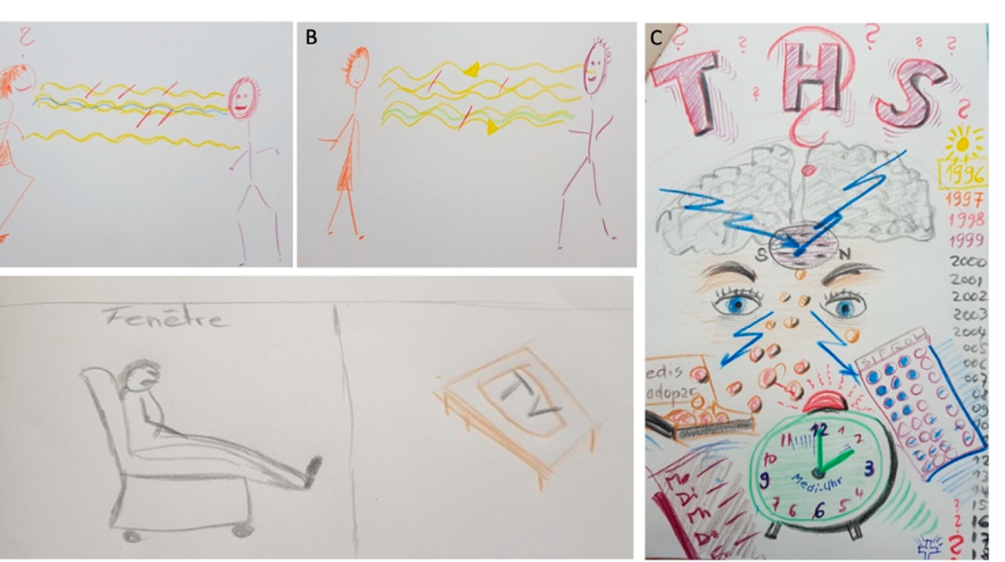
Figure 2. Individual perceptions of DBS effects by caregivers as published by [47]. A and B by Caregiver 1: preoperative ( A ) and postoperative ( B ) caregiver’s perception of her husband’s facial expression and improved communication after DBS. ( C ) Caregiver 2: caregiver’s perception of daily, chaotic, fast-paced timetables with appointments or tablet intake on time but hopeful eyes for better symptom control with DBS. ( D ) Caregiver 3: caregiver’s perception of postoperative fatigue and apathy of her husband.